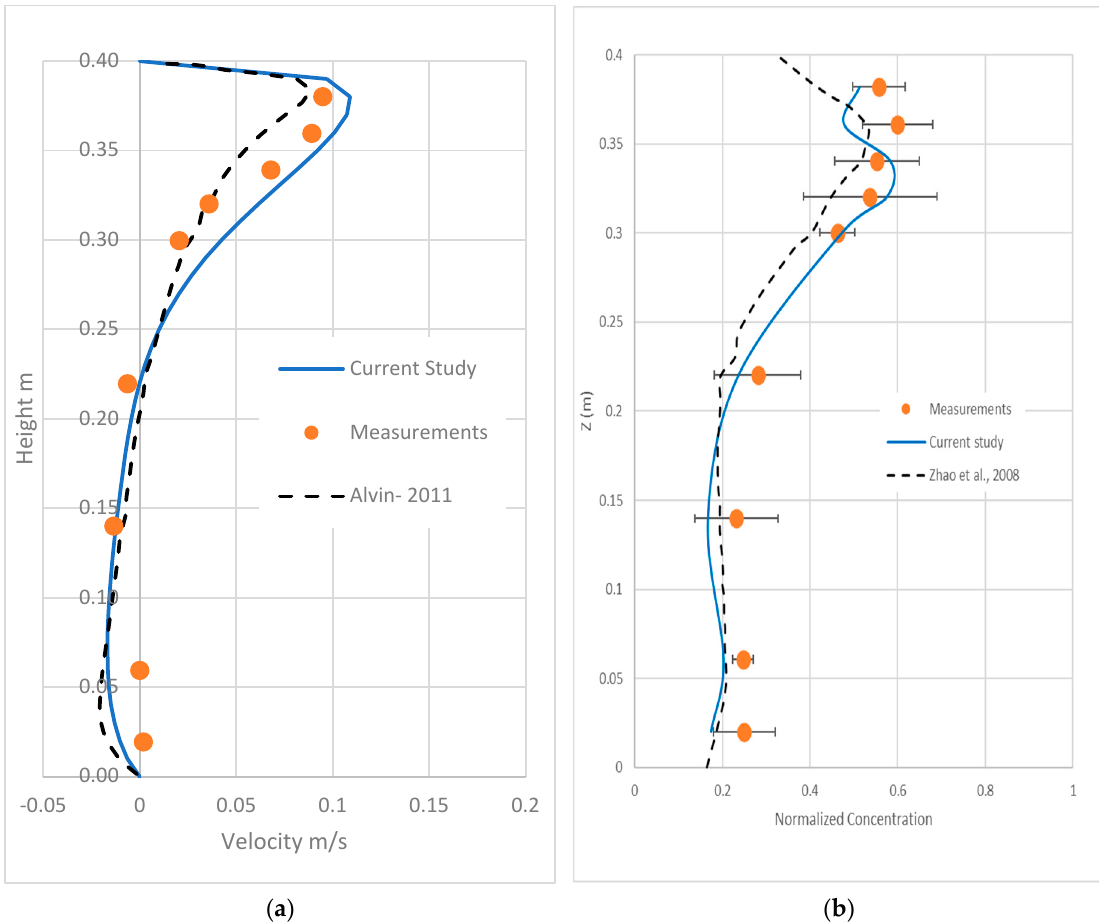
Figure 3. Measured and calculated velocity and concentration profiles for the first validation experiment at the center plane at x = 0.4 m. ( a ) Velocity profile. ( b ) Particle concentration profile.